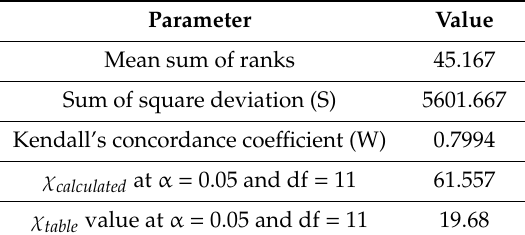
Table 8. Test of harmony in group